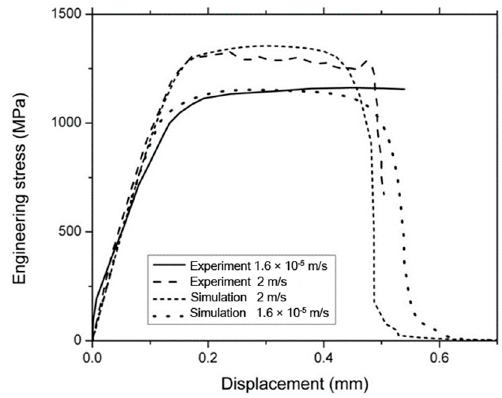
Figure 9. The U-notched plane strain sample. Effect of the loading rate on the model response. Experimental data by Verleysen and Peirs [43].